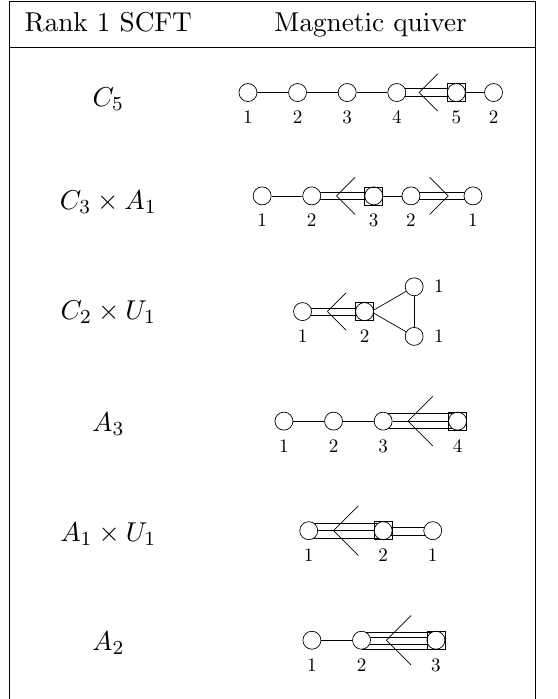
Table 2 . The magnetic quivers of 4 d (labeled by their global